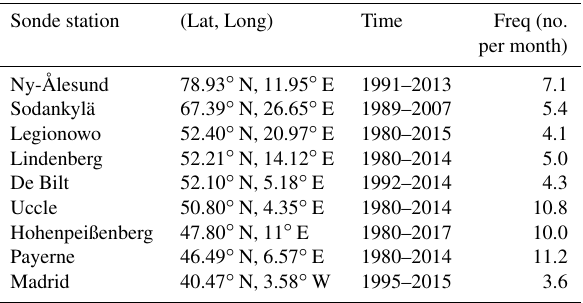
Table 2. The longitude, latitude, measurement time period and mean sampling frequency of the selected European ozonesonde sites. (Lat, Long) Freq (no. per